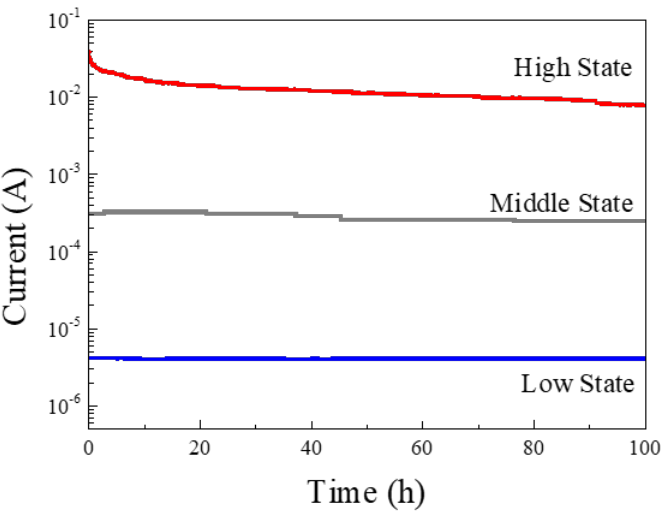
Figure 8. Retention characteristics of the fabricated memory device by measuring the current at 0.5 V after applying write voltage (2/2.7 V).